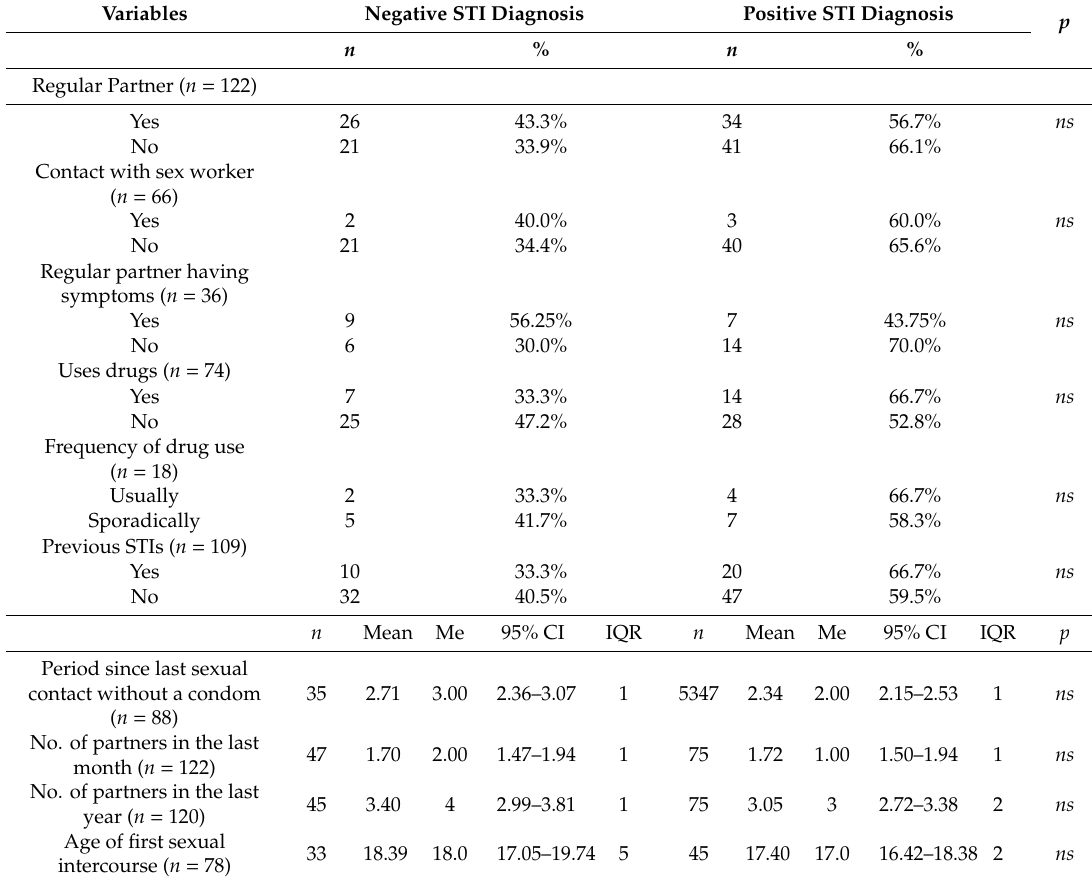
Table 4. STI diagnosis vs. Risk